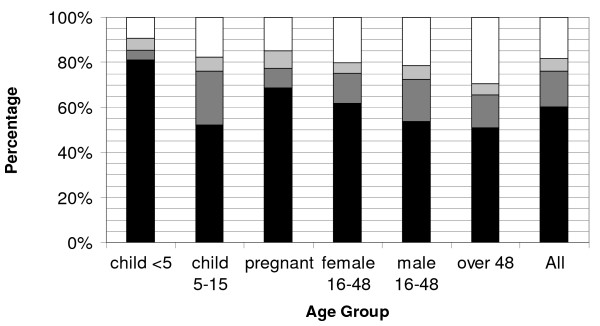
Age specific breakdown of individuals in each of the four ITN use categories during the rainy season following an integrated campaign targeting children <5 years of age in Madagascar. Denominator includes all persons in respective age group. ITN use categories are: white: living in households with no ITN present; light grey: living in households owning but not hanging an ITN; dark grey: living in households that have an ITN hanging but are not sleeping under an ITN; and black: sleeping under an ITN. Female 16-48 includes non-pregnant women of reproductive age.